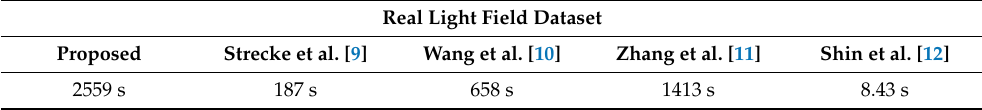
Table 8. Average runtime for real